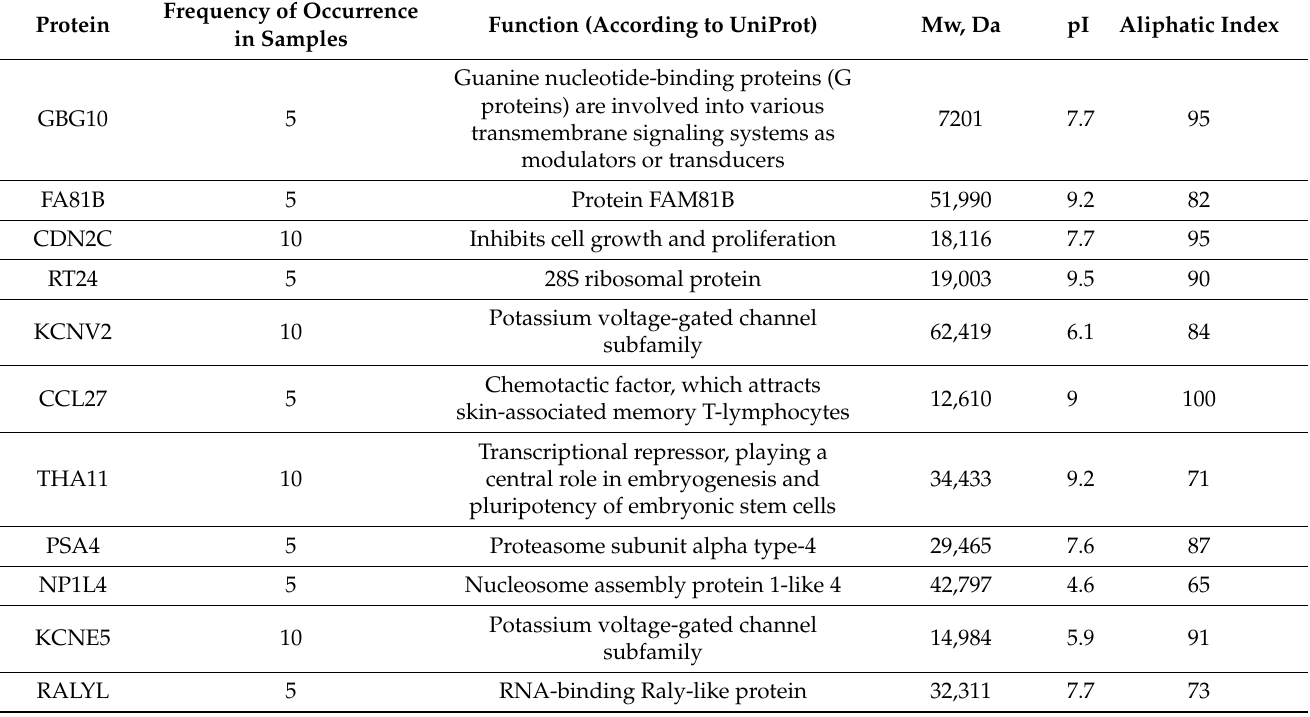
Table 3. Proteins revealed on the surface of the chips, bearing an array of sensor areas with covalently immobilized oligonucleotide probes, after the incubation in samples of individuals from two comparison